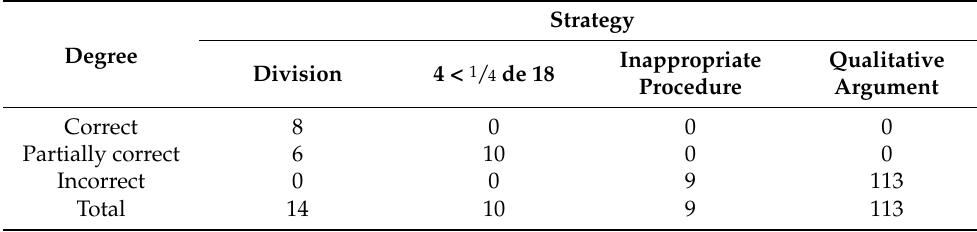
Table 9. Degree-strategy frequencies of Q5.